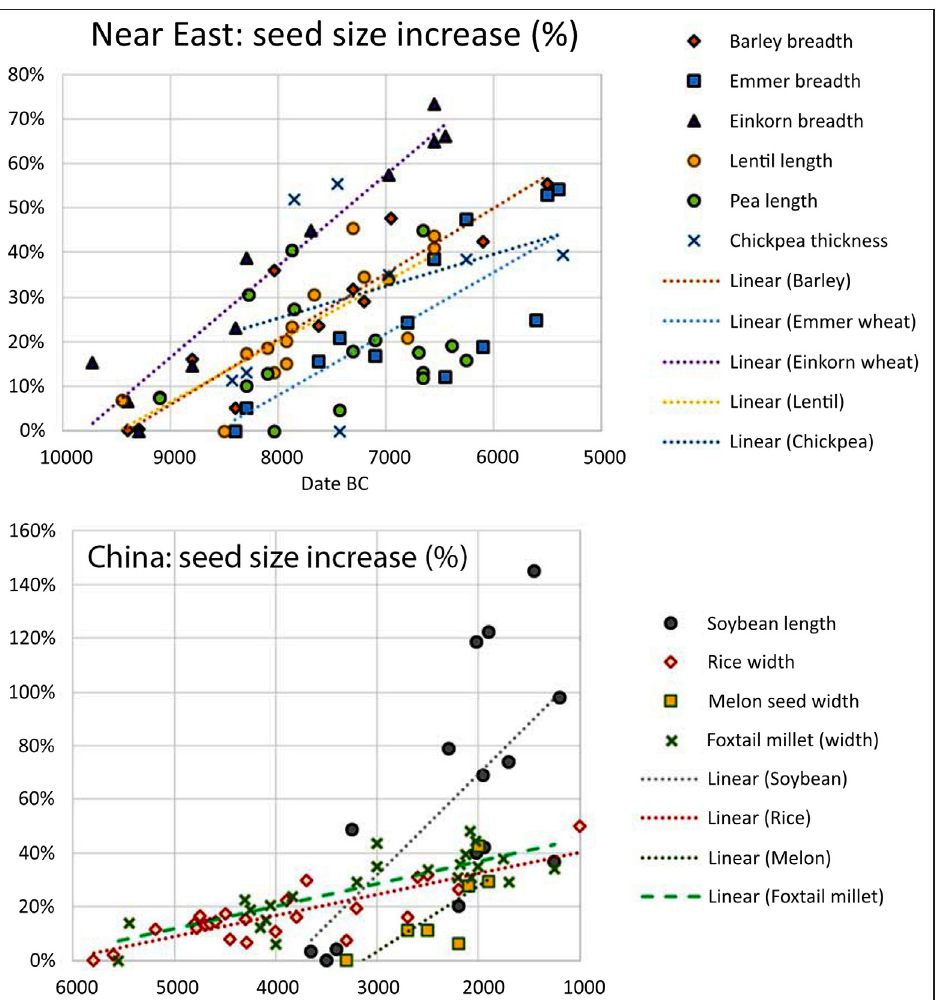
Figure 1: Showing size increase plotted on the Y-axis against time on the X-axis for the major crops from the Near East (top) and China (bottom) . Average grain and seed size data for given sites and time periods from archaeobotancial data based on that in Fuller et al.